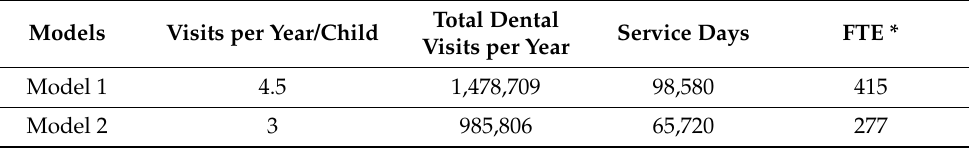
Table 1. The number of dentists required for school dental services presented in 2 models for Al-Madinah. Models Visits per Year/Child